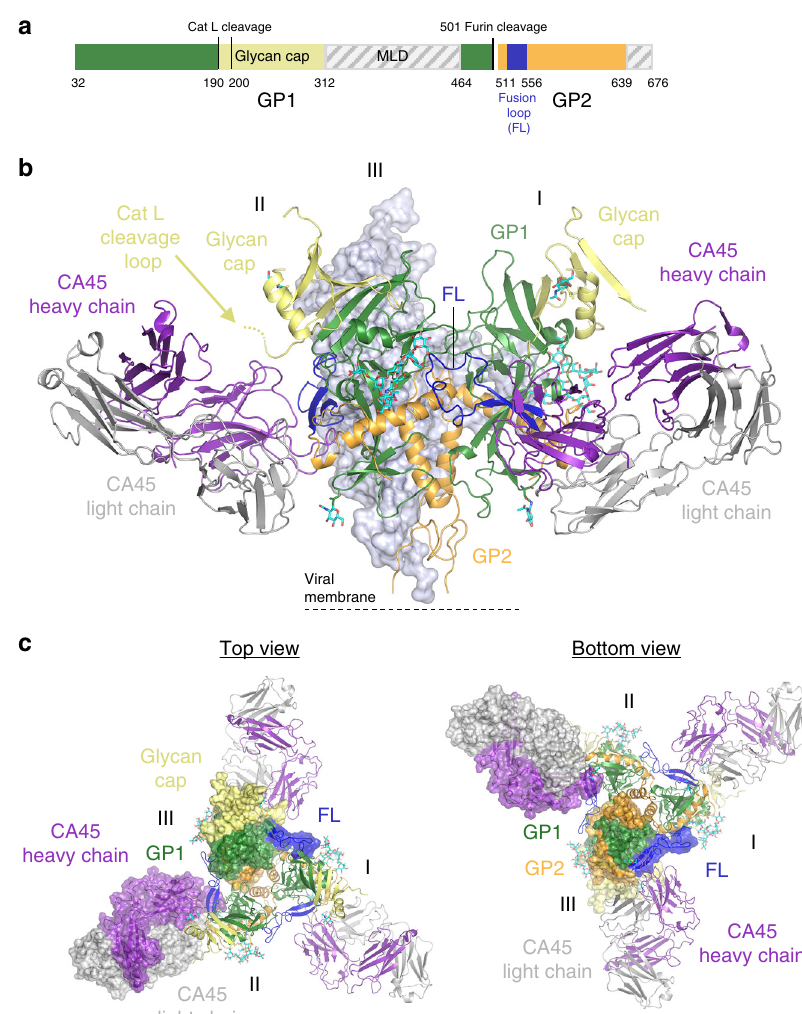
Fig. 1 Crystal structure of EBOV GP Δ Muc bound to CA45 Fab. a Schematic of the EBOV GP Δ Muc construct used in crystallizations, with the mucin-like domain (MLD) and transmembrane (TM) domain deleted (gray hatch). b Side view of crystal structure of trimeric EBOV GP Δ Muc (GP1, green, with glycan cap yellow; GP2, orange, with fusion loop (FL) blue) bound to CA45 Fab (heavy chain purple; light chain gray). Protomer III in the back is shown in light blue surface representation for clarity. c Top and bottom views of structure in b , shown in combined surface and cartoon representations with all protomers colored by subunit and